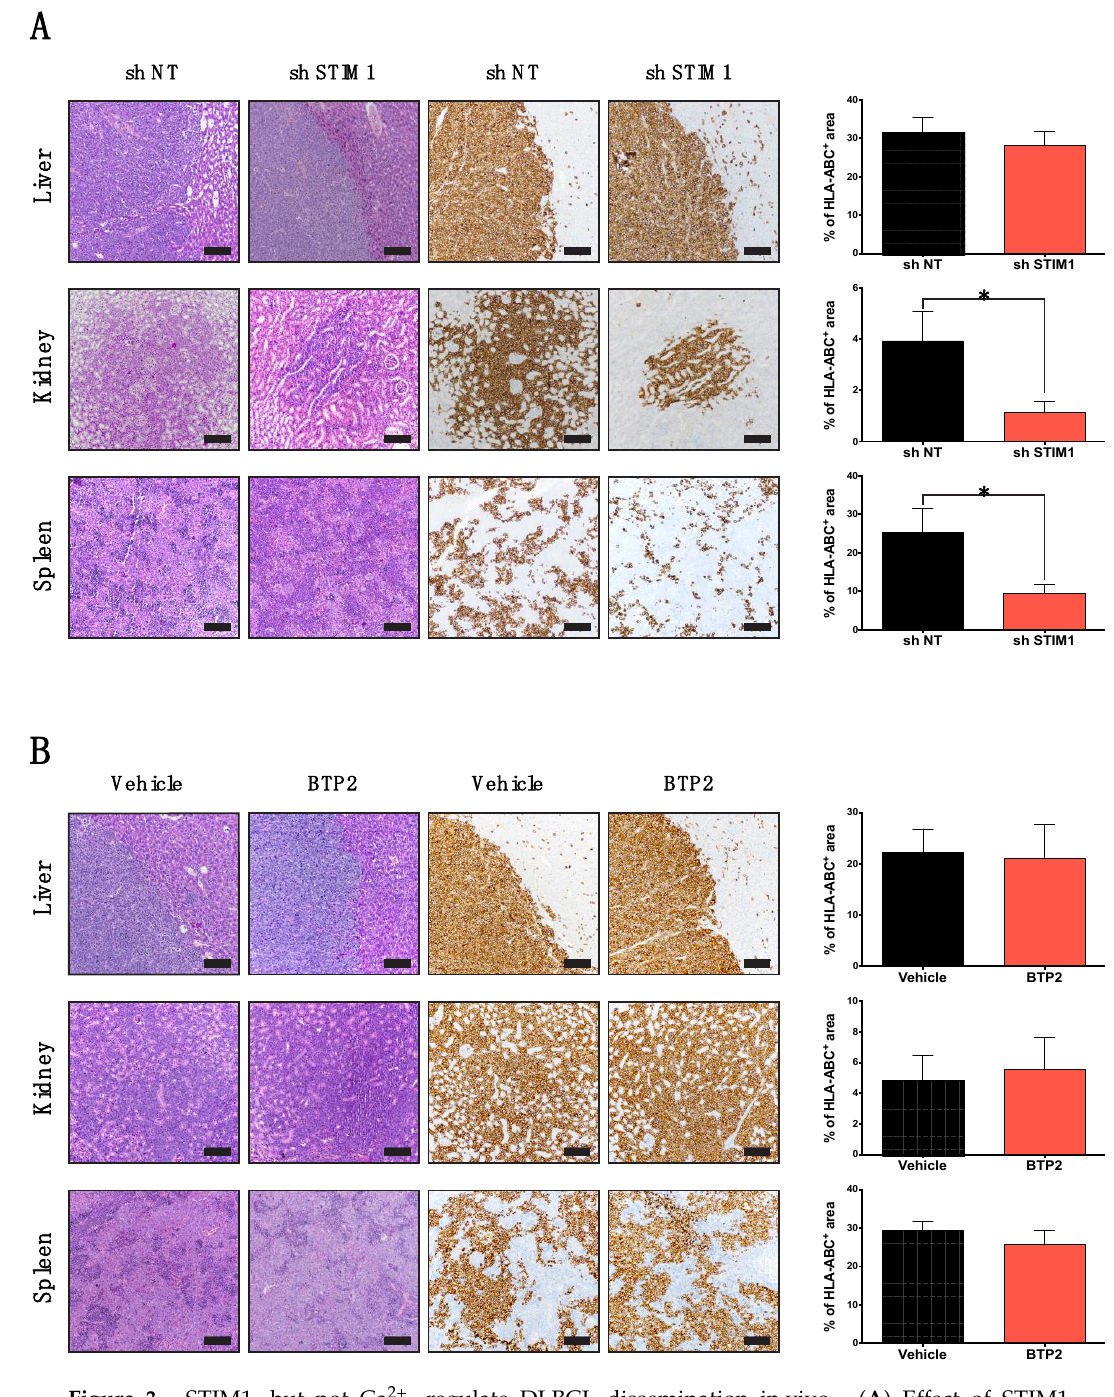
Figure 3. STIM1, but not Ca 2+ , regulate DLBCL dissemination in vivo. ( A ) Effect of STIM1 under-expression on HLY-1 cell dissemination. ( B ) Effect of intraperitoneal injection of BTP2 (12 µ g/kg) or vehicle, three times per week on HLY-1 cell dissemination. Images were captured with a Nikon Eclipse Ci microscope equipped with a Plan Fluor 10× 0.3 NA objective. Scale bars = 150 μm. Histograms represent the quantification of positive surface for HLA-ABC staining. All tissues were delimited and to evaluate the percentage of positive surface for HLA-ABC staining on tissue, thresholding on positive and negative staining was done using Mercator software. Data are represented as mean ± SEM (n = 10), * p < 0.05.